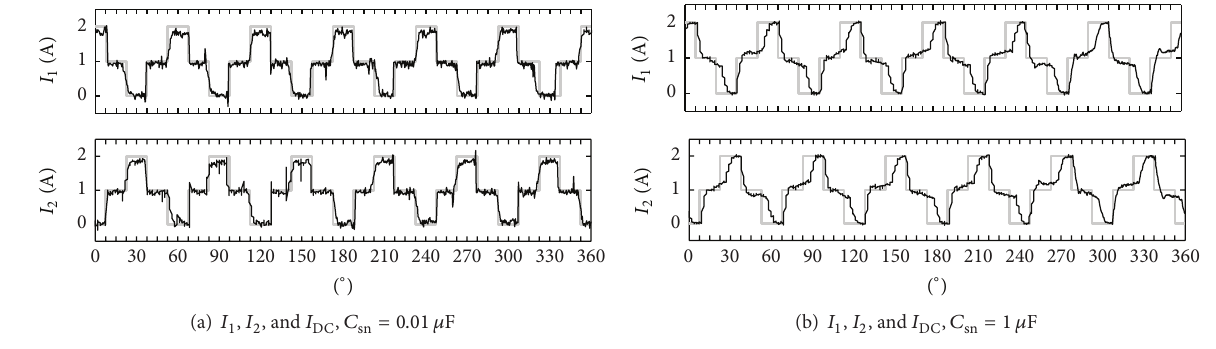
, 𝐼 𝑗 , and 𝐼 inj . 1 2